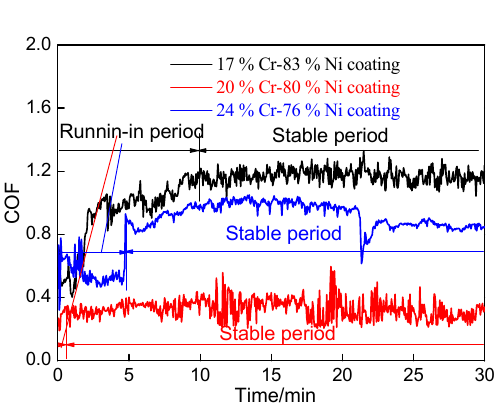
Figure 11. COFs of Cr–Ni coatings vs wear time.